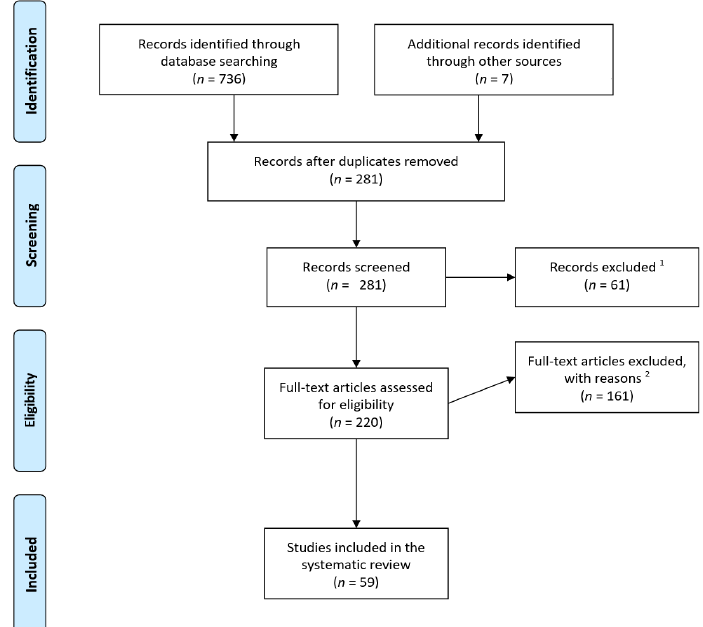
Figure 1. PRISMA flow diagram indicates the selection process of publications related to conceptual